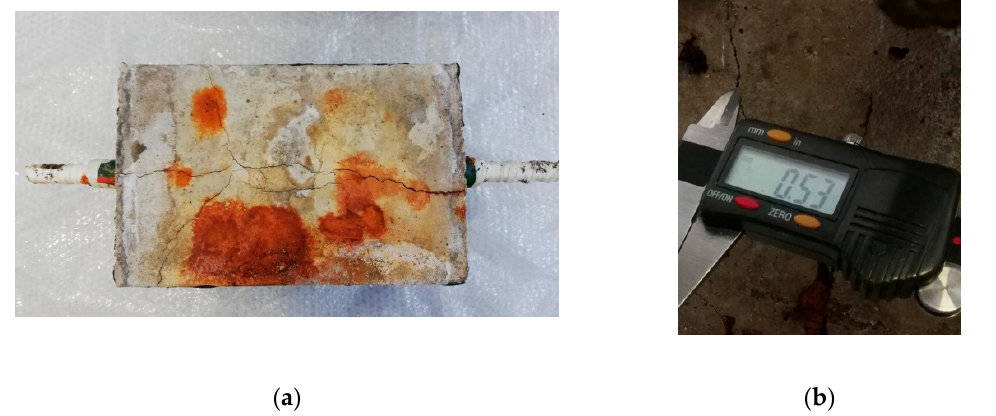
Figure 5. ( a ) Surface concrete cracking due to steel corrosion. ( b ) Measuring of crack width on